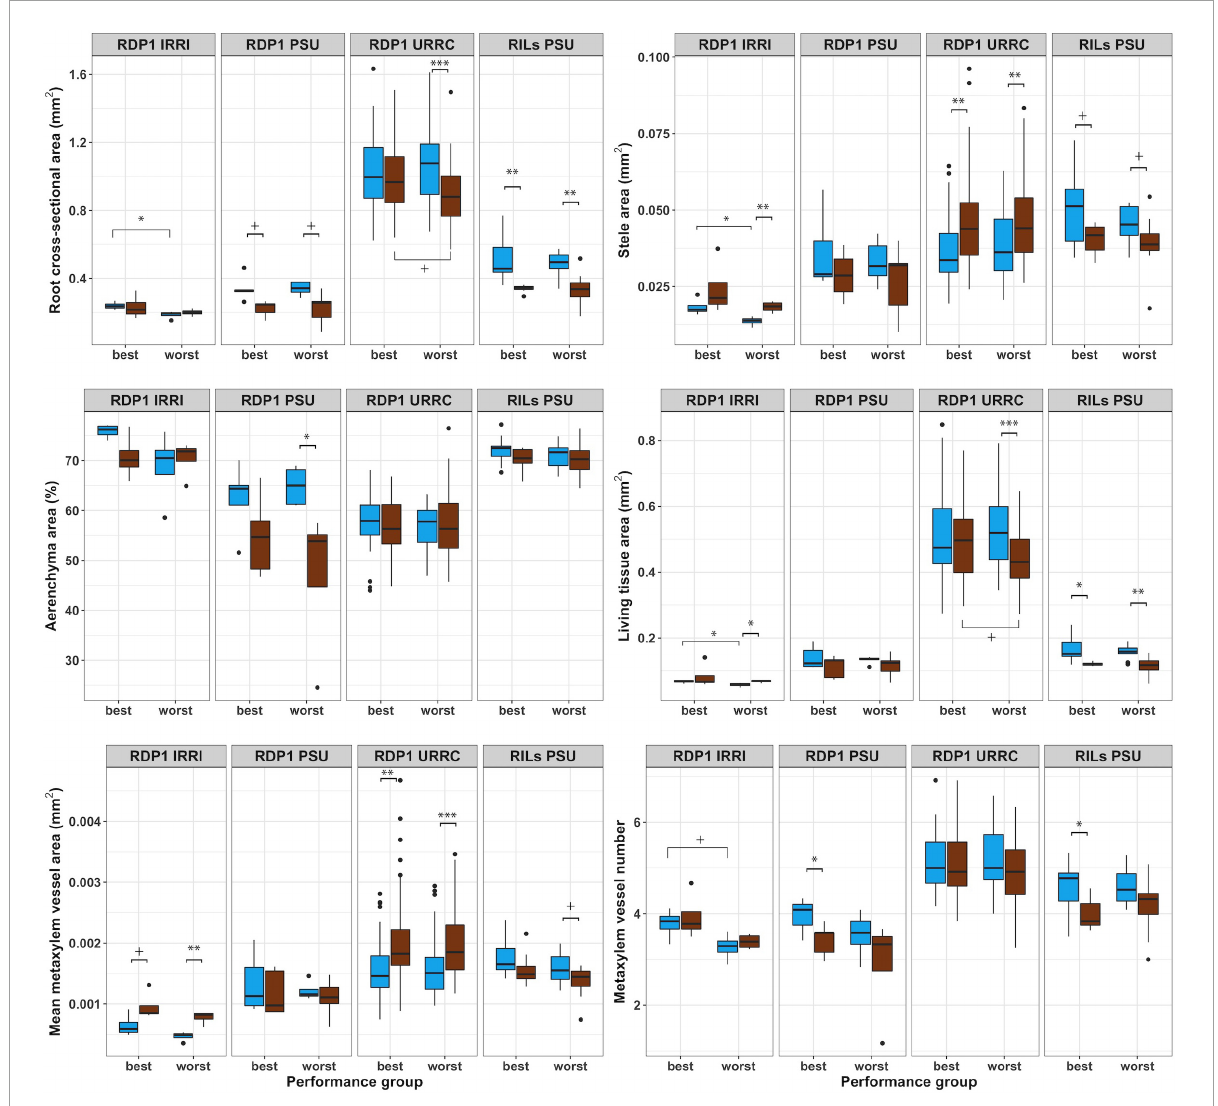
FIGURE3 Boxplots of root anatomical phenotypes of best and worst groups. Root anatomical phenotypes under well-watered (blue) and drought (brown) treatments in best and worst performing groups within each experiment location. Significance levels ( p -value < 0.1 + , 0.05 ∗ , 0.01 ∗∗ , 0.001 ∗∗∗ ) are shown for t -tests between treatments and performance groups within each experiment.